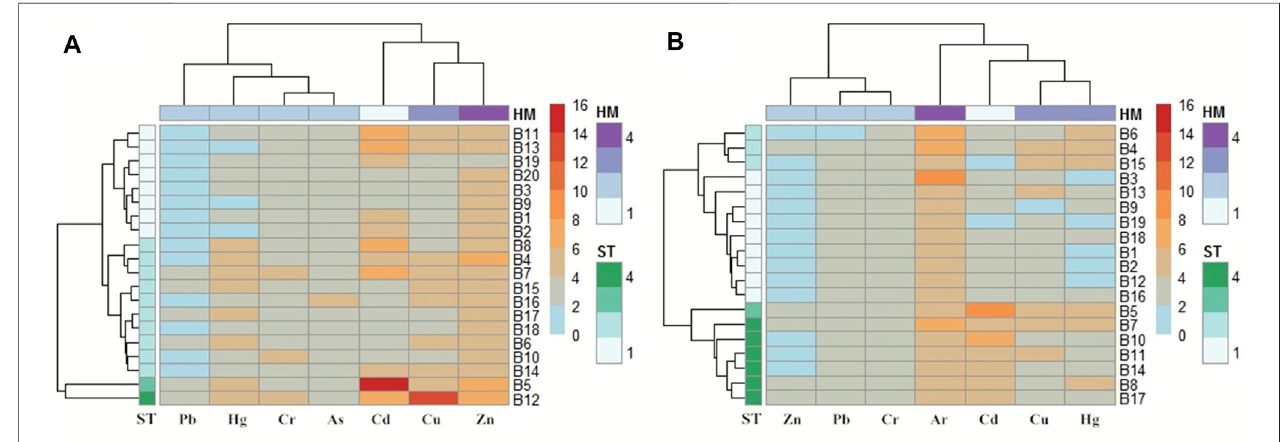
FIGURE9| Dendrogram obtained based on hierarchical agglomerative clusteranalysis(HACA) for (A) the relationship betweenheavy metals insurface sediments and contributing sites in spring and (B) the relationship between heavy metals in surface sediments and contributing sites in autumn, in Daya Bay in 2016.